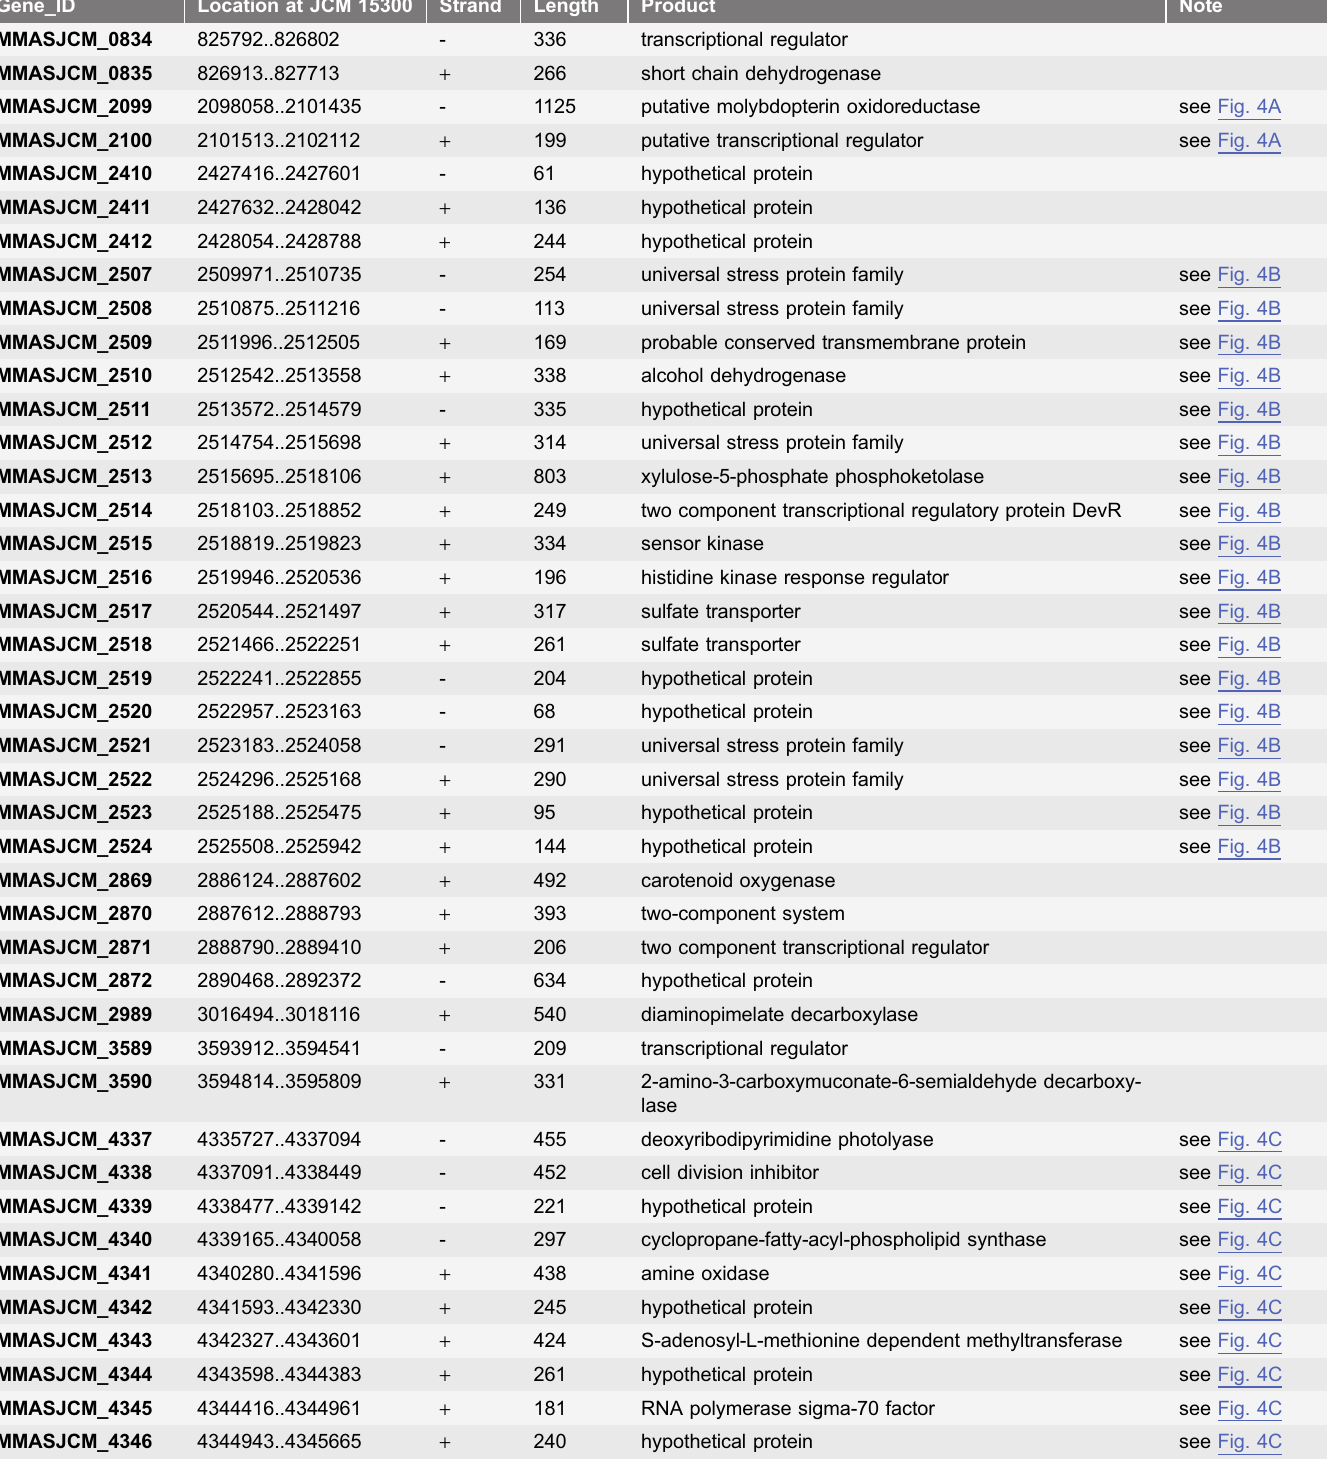
Table 2. The unique conserved gene loci in massiliense cluster among M. abscessus